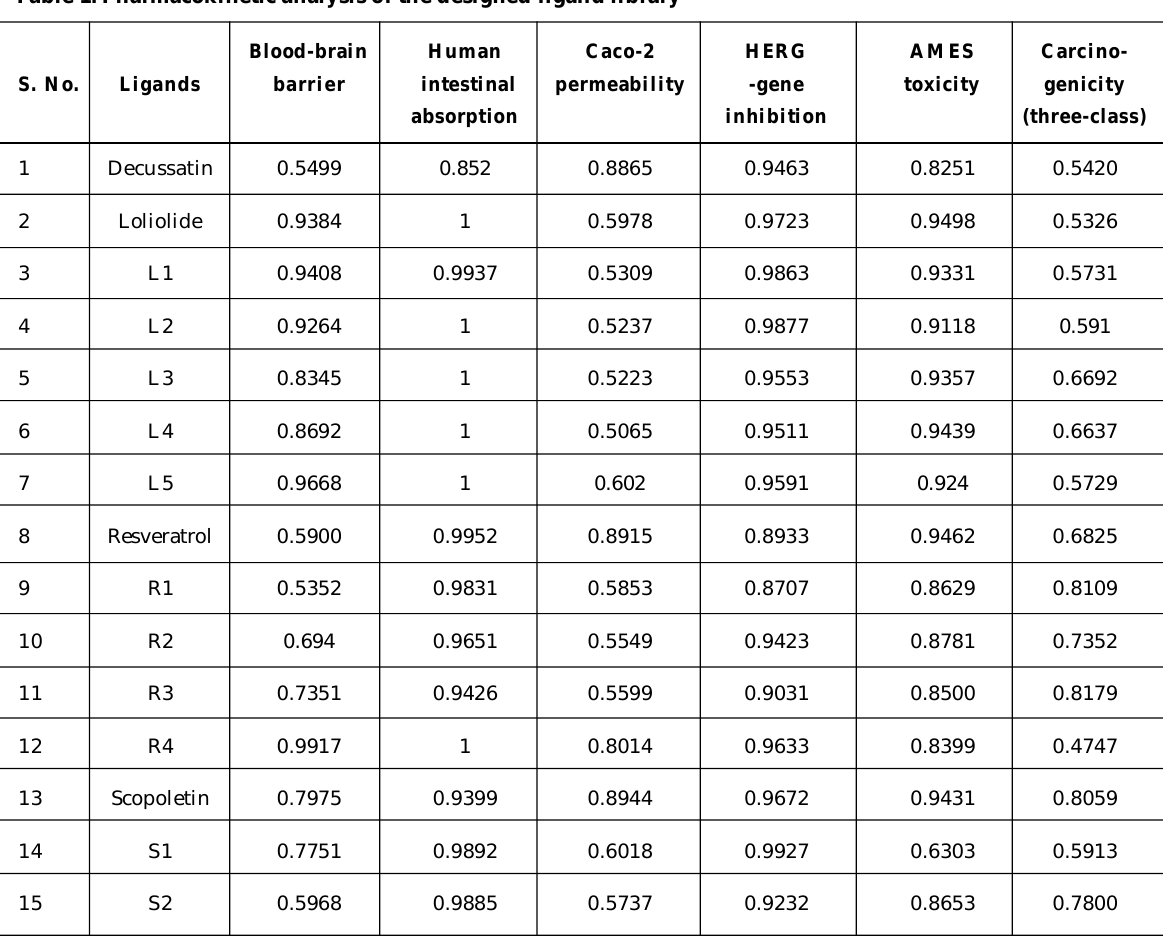
Table 1. Pharmacokinetic analysis of the designed ligand library Blood-brain Human Caco-2 HERG AMES Carcino- S.